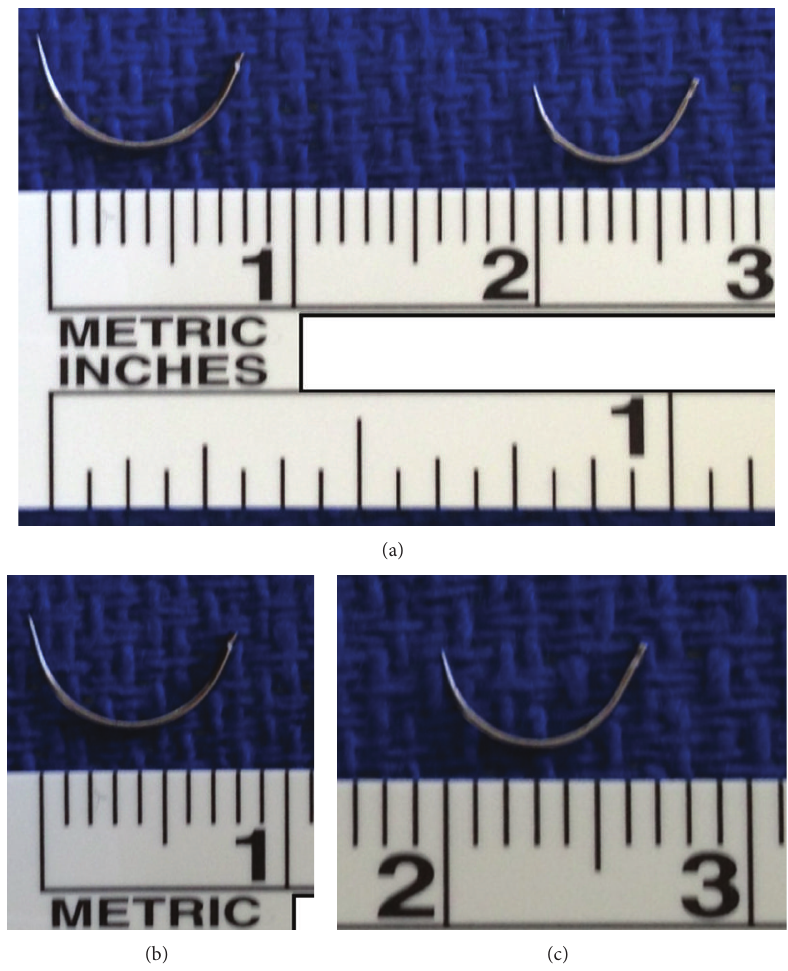
Figure 2: (a) CV-22 (right) and CV-20 (left) needles next to each other for comparison, (b) CV-22 taper needle is 1/2 circle with 13mm diameter, and (c) CV-20 taper needle is 1/2 circle with 10mm